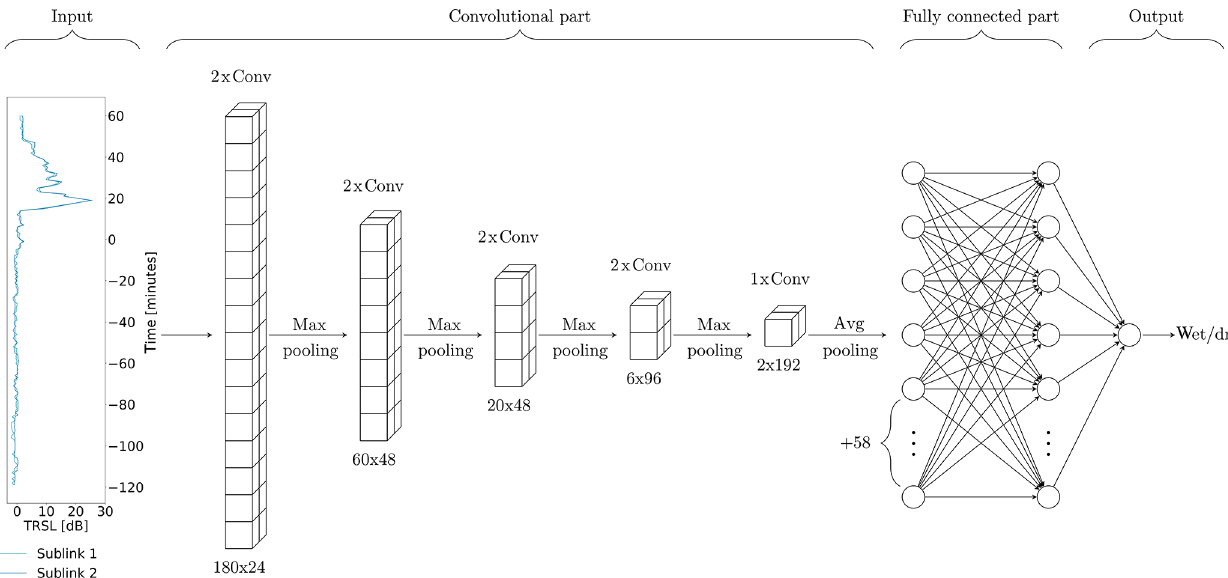
Figure 3. Graphical illustration of the CNN’s architecture for k = 120. The input shows one sample X t,i of data consisting of 180min of TRSL from the two sublinks of one CML. Convolutional and pooling layers reduce the input dimension from 180 to 2, while a total of 192 features are extracted. Numbers below convolutional layers are the layer output dimensions, i.e., input dimension times the number of filters. The size of the local patch in a convolutional layer is 3. Based on the extracted features, the fully connected layers predict a class, which is stored in the output